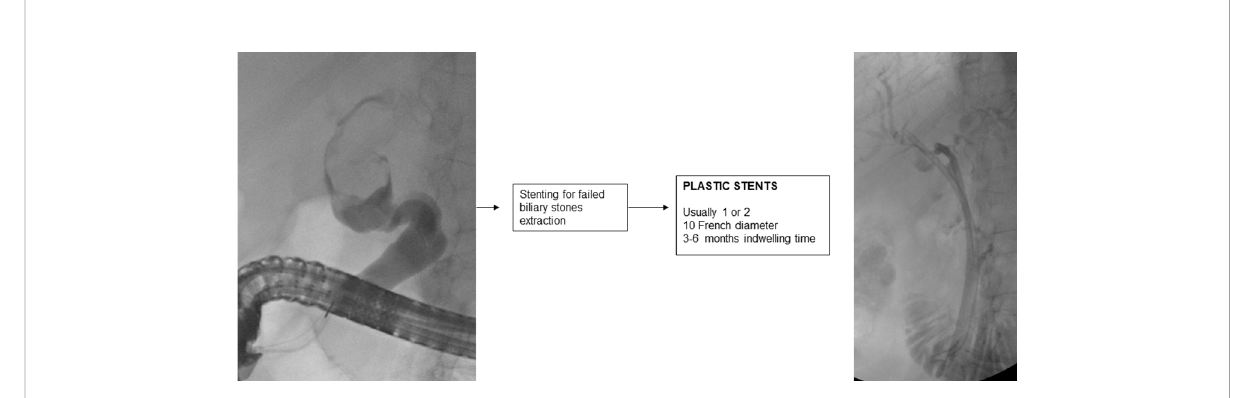
FIGURE 5 Biliary stenting for failed stones extraction.